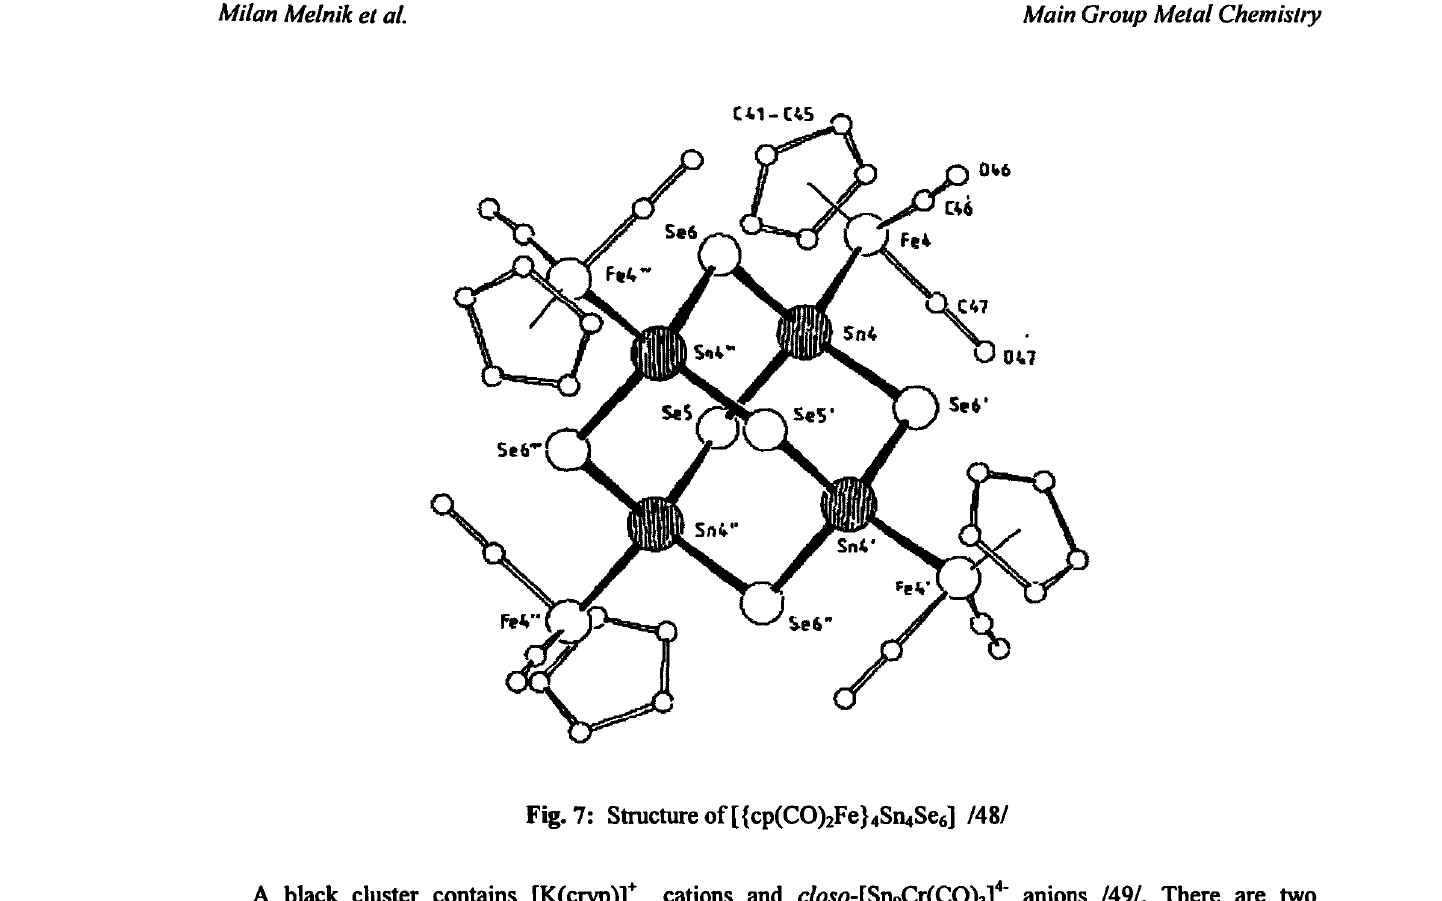
Fe} Sn4Se ] /48/ 2 4 6